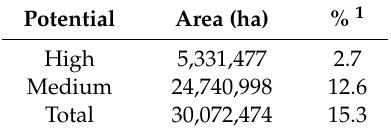
Figure 5. Agroecological spatial areas estimated for JCL cultivation in Mexico, scenario 1. High potential (green polygon), medium potential (yellow polygon) and low potential (red polygon). Table 15. Available areas for JCL cultivation in Mexico, scenario